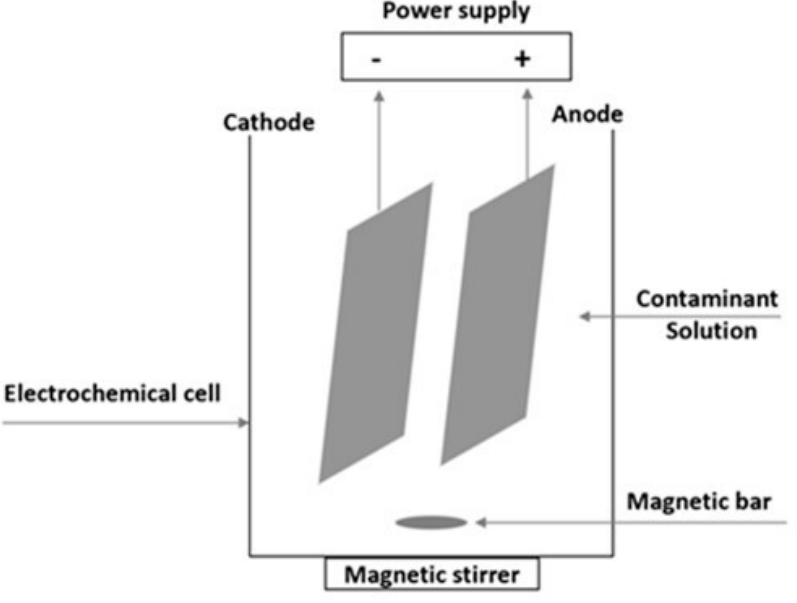
Figure 7. Schematization of the electrochemical reactor.